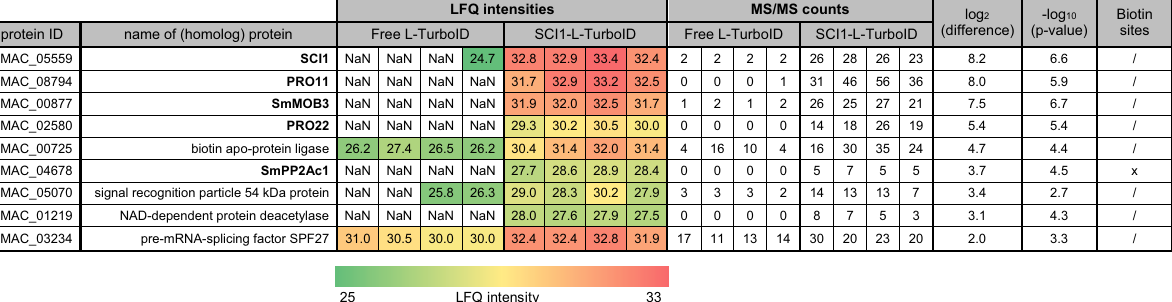
separated with SDS-PAGE. Proteins were digested with trypsin in-gel prior to l iquid c hromatography- m ass s pec- trometry (LC–MS) analysis. The reproducibility of the four biological replicates from both strains was high, as indicated by mean Pearson correlations of 0.9556 among Δsci1::p5’-sci1-L-TurboID ect replicates, and 0.9676 among the control replicates. A total of 1185 proteins were identified. The L abel F ree Q uantification (LFQ) intensities and MS/MS counts of proteins significantly enriched against the negative control (enrichment factor ≥ 4) are listed in Table 2. The SmSTRIPAK components SCI1, PRO11, SmMOB3, PRO22, and SmPP2Ac1 were identified among the top hits. One peptide of SmPP2Ac1 was found to be biotinylated at residue K308. The volcano plot in Fig. 5 shows